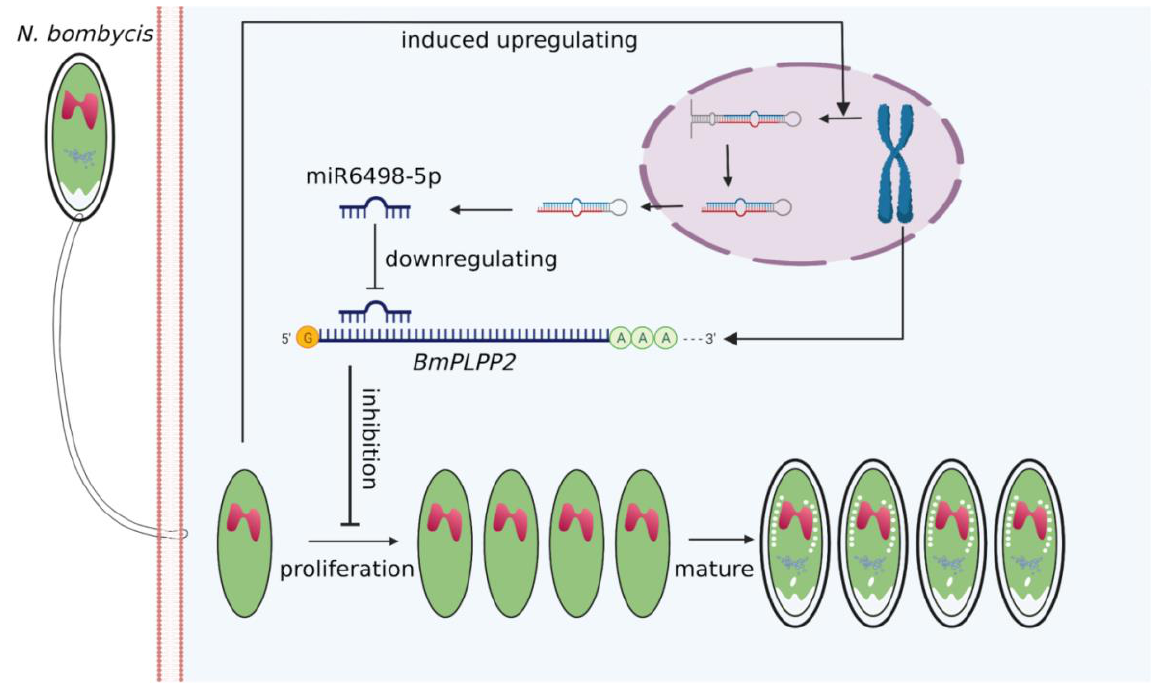
Figure 7. Model for host miR6498-5p inhibits N. bombycis proliferation by downregulating BmPLPP2 .